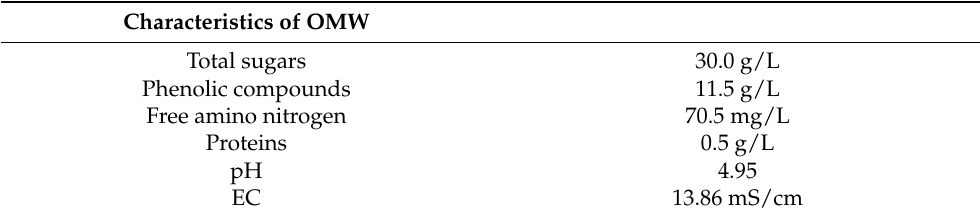
Table 1. Characteristics of olive mill wastewater (OMW) used in the present